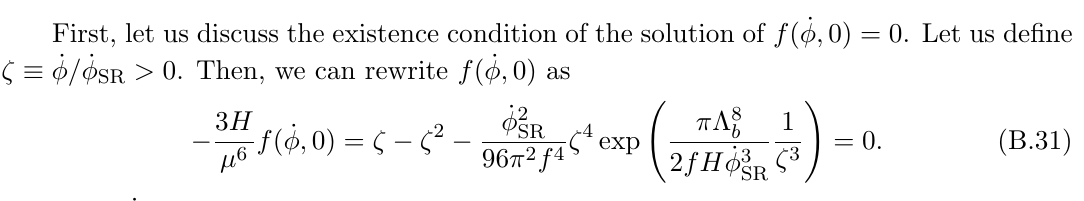
Figure 23 . (cid:127) (cid:30) as a function of _ (cid:30) . Here we take f = 10 3 , H = 10 (cid:0) 7 , and (cid:22) 3 = 3 (cid:2) 10 (cid:0) 6 in the unit of (cid:3) b =